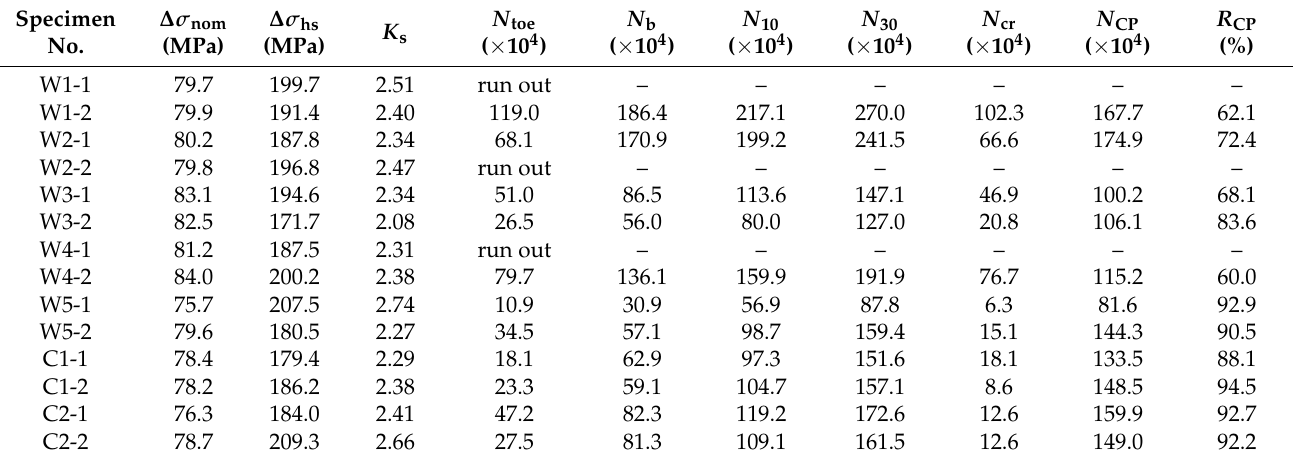
Table 3. Summary of fatigue test results.